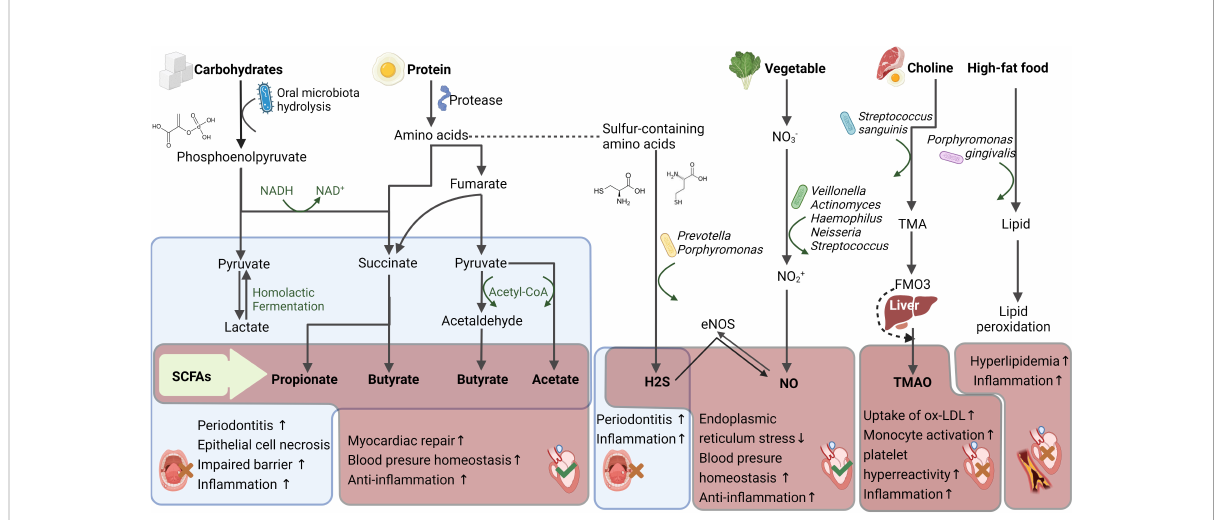
FIGURE 3 Oral microbiota metabolites and its impact upon cardiovascular health. The oral microbiota produce short chain fatty acids (SCFAs), hydrogen sul fi de (H 2 S), nitric oxide (NO), trimethylamine oxide (TMAO), lipids and other metabolites from the digestion of different foods, which affect oral and cardiovascular health. The red box displays the cardiovascular effects of the metabolites and the blue displays the oral effects. Red wrong number refers to harmful, while green right number refers to bene fi cial. DANH/NAD+, Nicotinamide adenine dinucleotide; ox-LDL, Oxidized- Low-Density Lipoprotein Cholesterol; Flavin-containing monooxygenase 3, FMAO3; Trimethylamine,